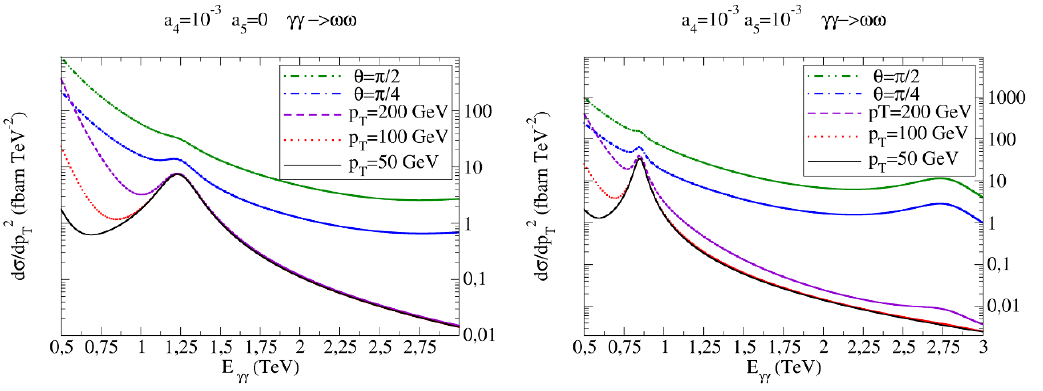
JHEP11(2018)010 Figure 3 . Di(cid:11)erential cross section for (cid:13)(cid:13) W L W L =Z L Z L at the indicated energy. Left: ! a 4 = 10 (cid:0) 3 , a 5 = 0. Right: a 5 = a 4 = 10 (cid:0) 3 as indicated. Both sets induce resonances around 1 TeV; the one at higher mass in the right plot is narrower ( f 2 -like) and the one common to both plots is an f 0 -like, broader structure. We show both (cid:12)xed-angle (in the CM) and (cid:12)xed- p t scattering. Figure 4 . Cross section for e (cid:0) e + e (cid:0) e + (cid:13)(cid:13) e (cid:0) e + !! , di(cid:11)erential respect to p 2 and the cm t ! ! energy of the photon ( ! ) pair. Left and right plots with the same parameters as (cid:12)gure 3. The e (cid:0) e + energy is (cid:12)xed at 2